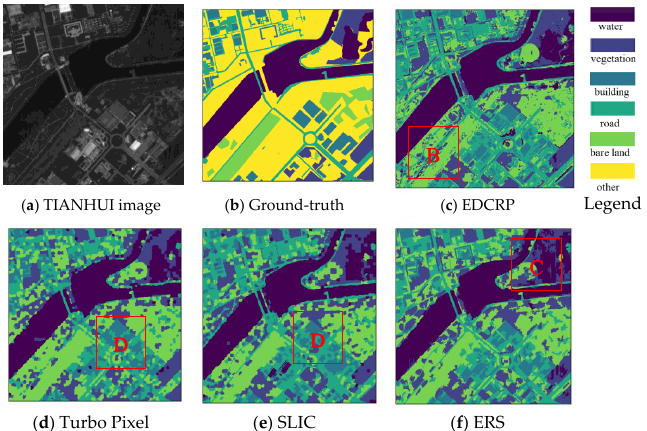
Figure 11. Classification maps of the TIANHUI image based on the over-segments; ( a ) is the TIANHUI image; ( b ) is the ground-truth of the image; ( c – f ) are the classification maps based on the over-segments produced by the EDCRP, Turbo Pixel, SLIC, and ERS, respectively. The legend shows the class labels in both the ground-truth and classification